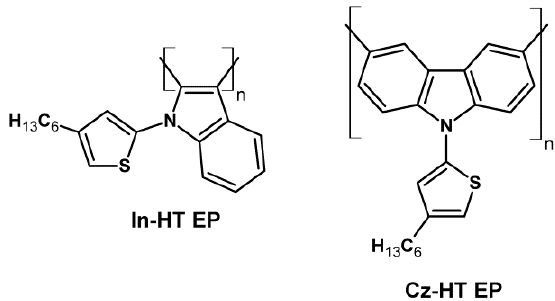
Figure 10. Ultraviolet-visible-near infrared (UV-Vis) spectra of polymeric films prepared from pure monomer solutions ( a ) and monomer solutions containing HT ( b ).